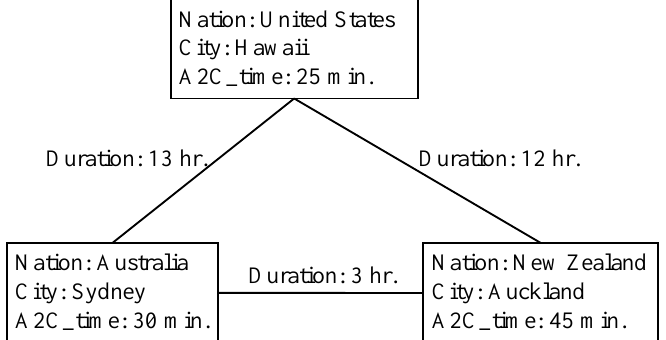
Figure 4. An example of data stored in a graph database.